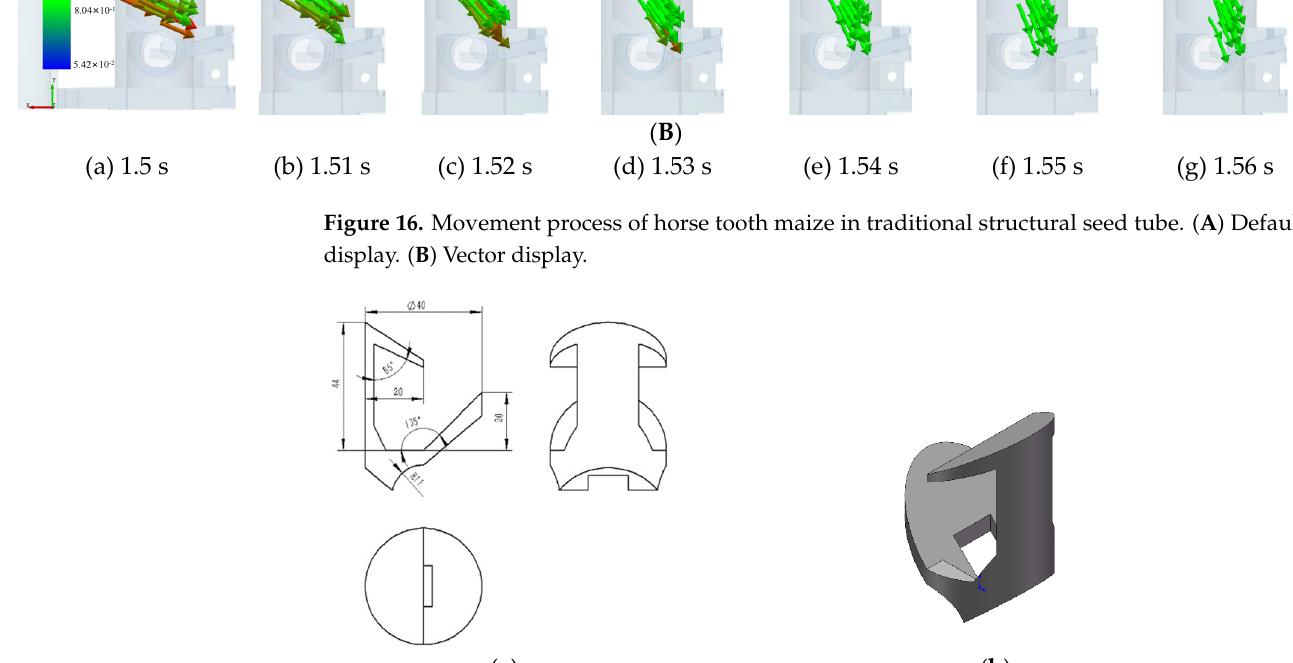
Figure 16. Movement process of horse tooth maize in traditional structural seed tube. ( A ) Default display. ( B ) Vector display.